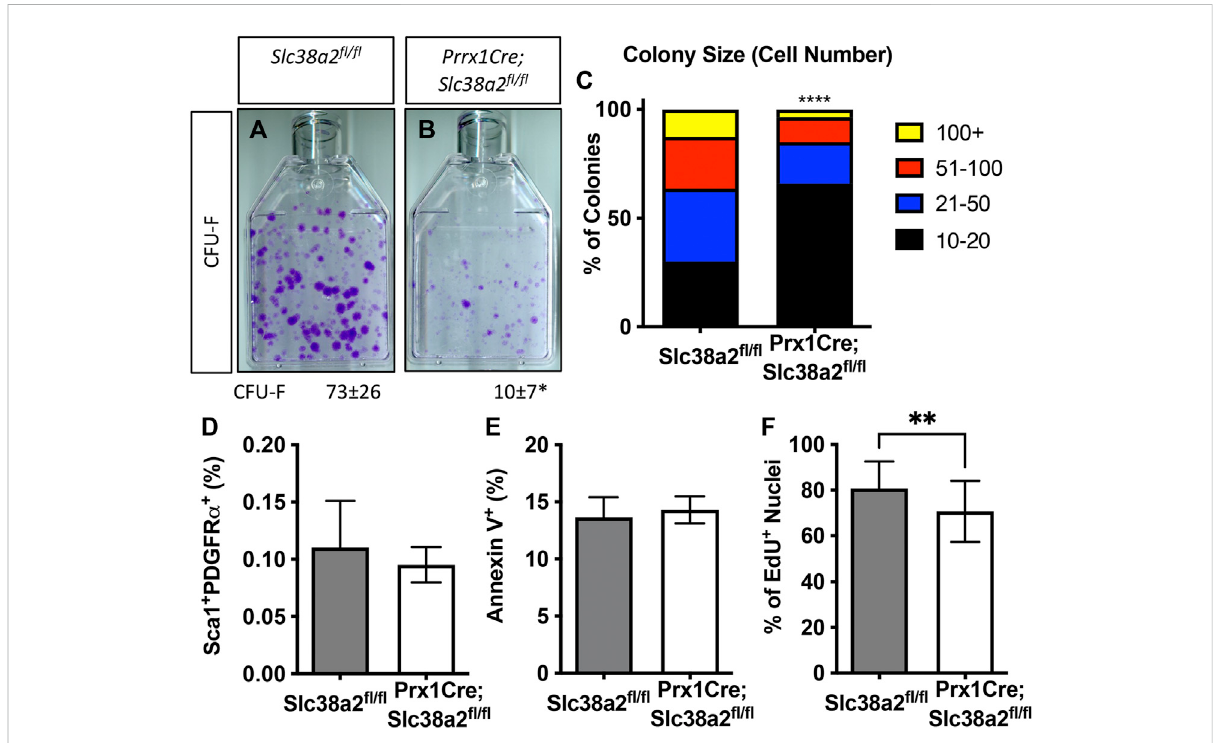
SLC38A2 activity is required for SSPC proliferation. (A,B) Representative images of colony forming unit (CFU) assays stained with Crystal Violet. Quanti fi cation ofthenumber ofcolonies containing atleast20cells isshown below eachpanel. * p < 0.05 n = 5miceeach genotype. (C) Prevalence of colonies binned for cell number. **** p < 0.00005. (D) Quanti fi cation of the CD45 − , PDGFRa + , Sca1 + population using fl ow cytometry. N = 3 mice. (E, F) Quanti fi cation the number of Annexin V positive cells (E) or EdU positive nuclei (F) . ** p < 0.005, N = 5